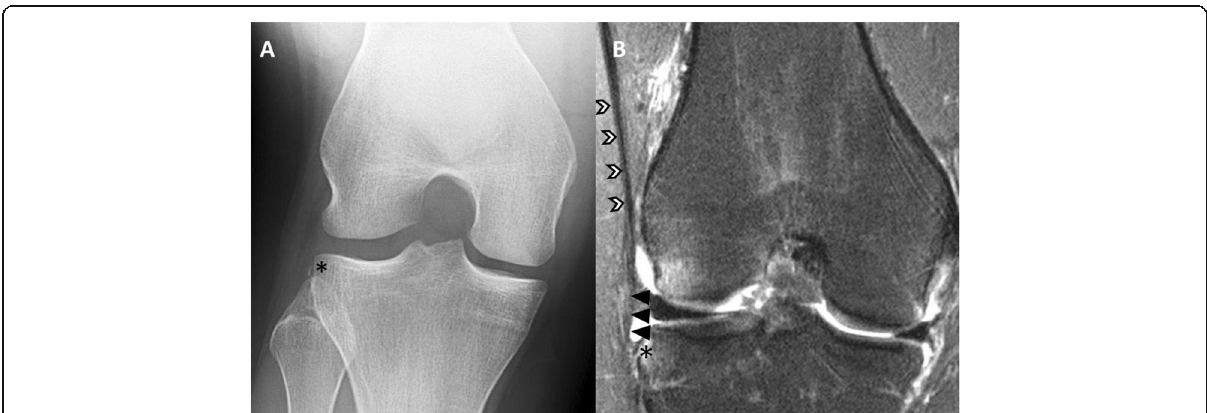
Fig. 1 Radiograph ( a ) and magnetic resonance imaging exam ( b ) of a Segond fracture with injury to the anterolateral capsule. The black star denotes the Segond fracture, or an avulsion fracture off the lateral tibial plateau. The black and white errors denote the iliotibial band, while the black arrows demonstrate the anterolateral capsule